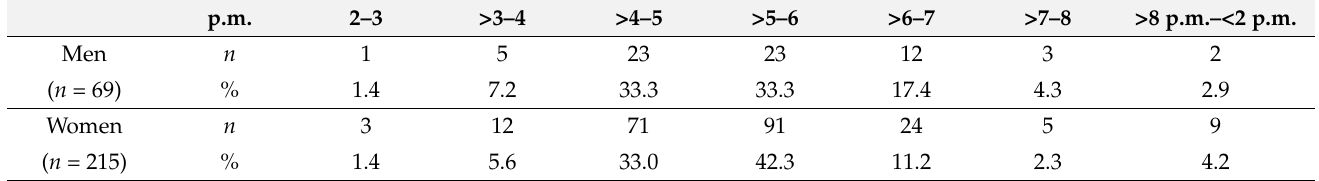
Table A3. The distribution of time when commuting from the place of work or study to home ( n participants and percentage within each sex).